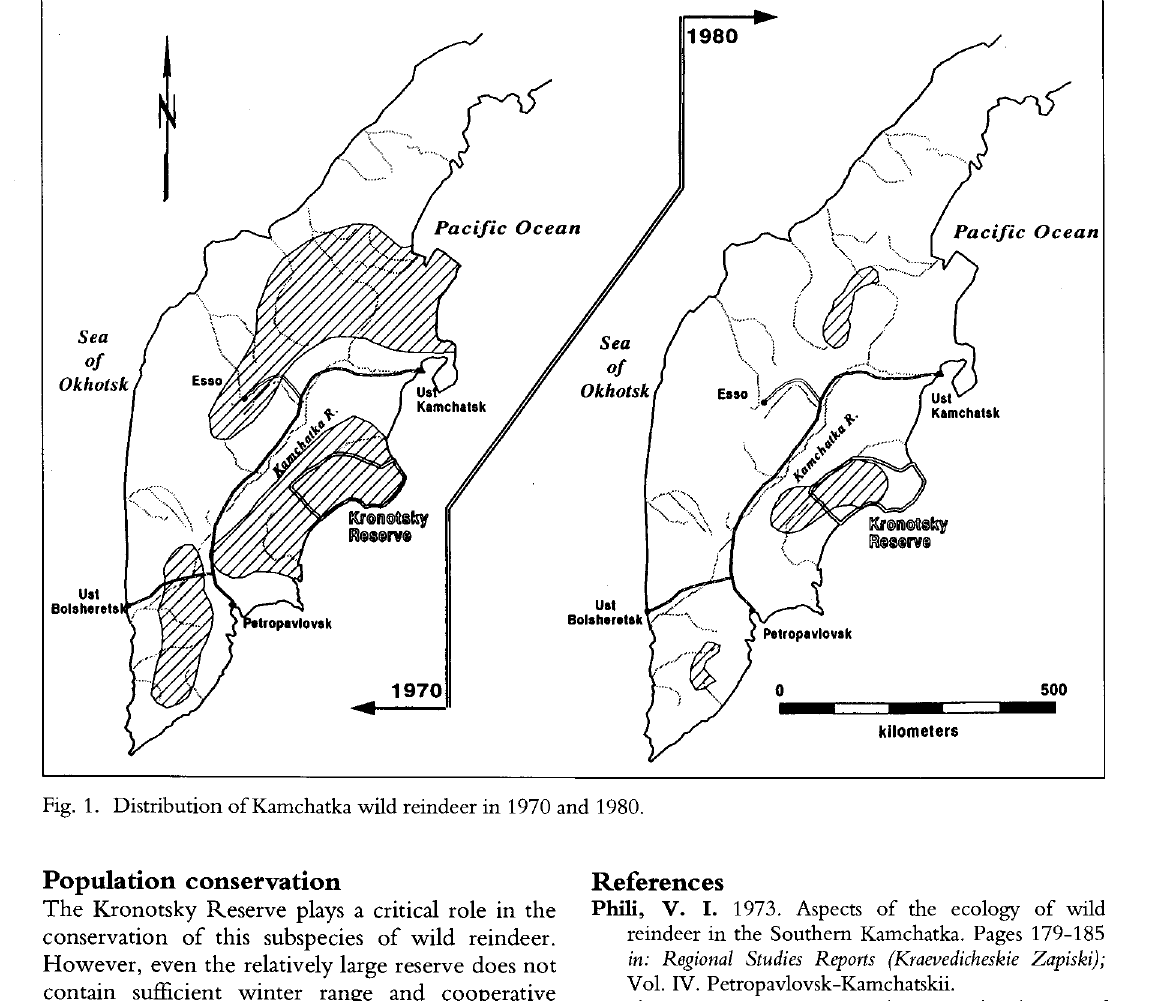
Fig. 1. Distribution of Kamchatka wild reindeer in 1970 and